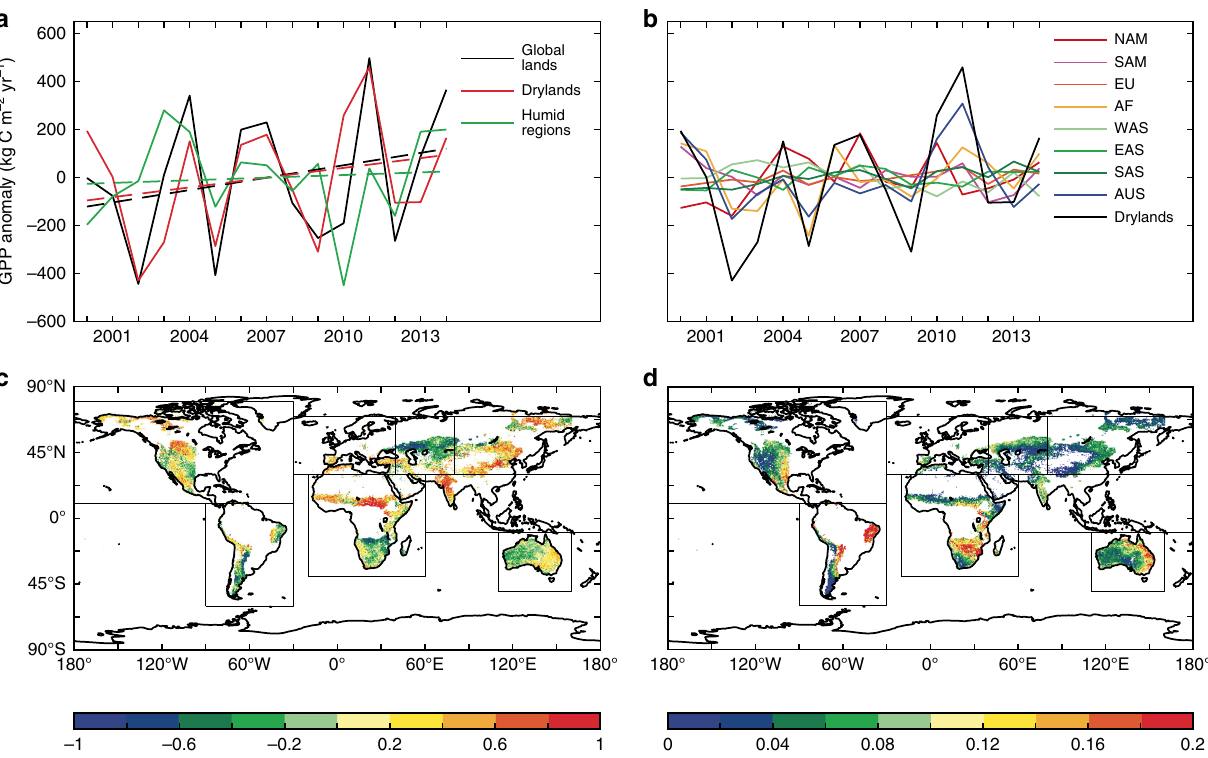
Fig. 1 MODIS-derived dryland GPP trend and variations from 2000 to 2014. a Variations of the annual gross primary production (GPP) anomaly for the global lands, global drylands, and global humid regions (2000 – 2014). The dotted line denotes the linear trend of GPP. Global drylands played the dominant role in modulating both the trend and the interannual variability (IAV) of the global land GPP, accounting for 79% of the increasing trend and 83% of the IAV of the global land GPP in 2000 – 2014, although they only contributed to 21% of the global mean GPP. b Variations of the annual GPP anomaly over the eight dryland regions in 2000 – 2014. NAM North America, SAM South America, EU Europe, AF Africa, WAS West Asia, EAS East Asia, SAS South